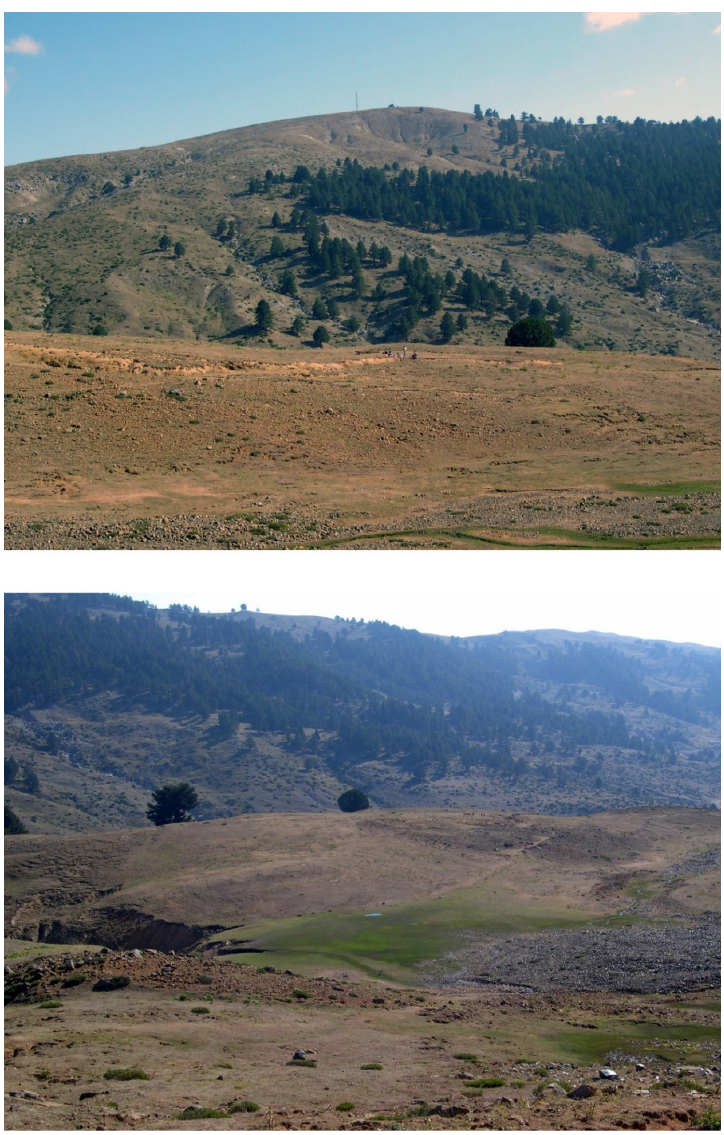
Figure 23. Historical Camp (HC): views from the lower slopes on Mount Gurguliu. Note Mount Kirkuri in the background and the location of the HC site excavation trench along the edge of the erosion gully, in the centre of the top photograph. Mount Kirkuri is visible in the background (photographs by P. Biagi, 2006).